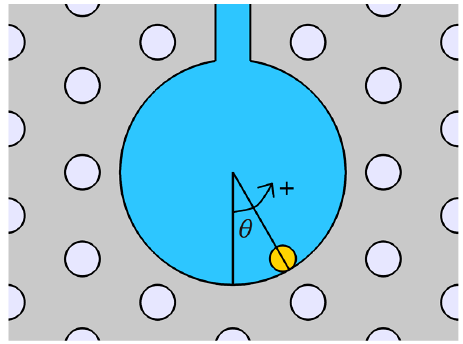
Figure 5. Schematic of the fiber hole filled with the gold nanowire.